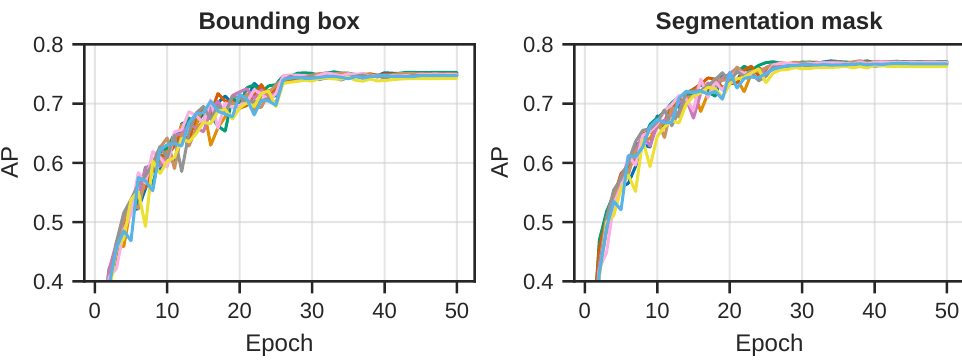
Figure 6. Evolution of the AP for both the detection and segmentation task, for each of the 10 runs, per epoch of training. Note that these results are based on evaluations using a maximum of 100 detections per image. ( Left ): The AP for the detection (bounding box) task. A plateau is reached after about 30 epochs. ( Right ): The AP for the segmentation mask task. We observe that the same type of plateau is reached here as with the detection task.